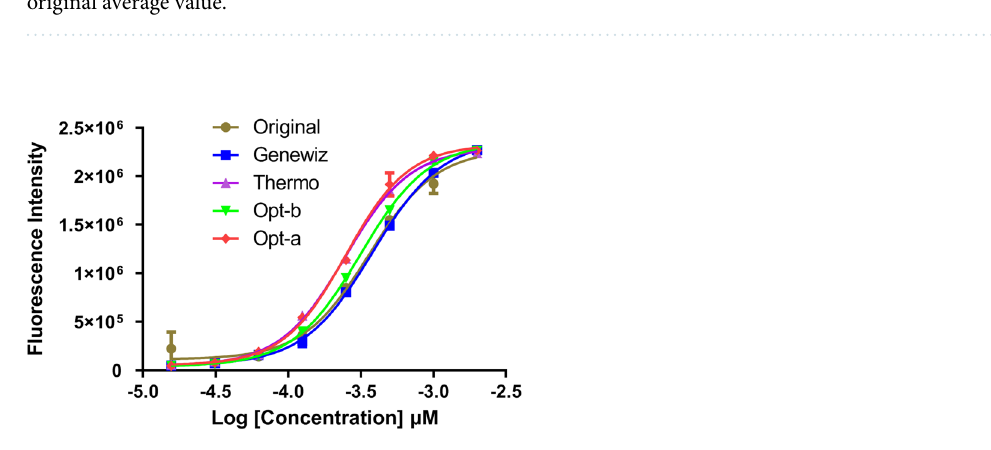
Table 5. Comparison of grayscale value ratios corresponding to Fig. 3b. The comparison of grayscale value ratios between PTP4A3 and GAPDH. The optimization ratio is the ratio of each method’s average value to the original average value.